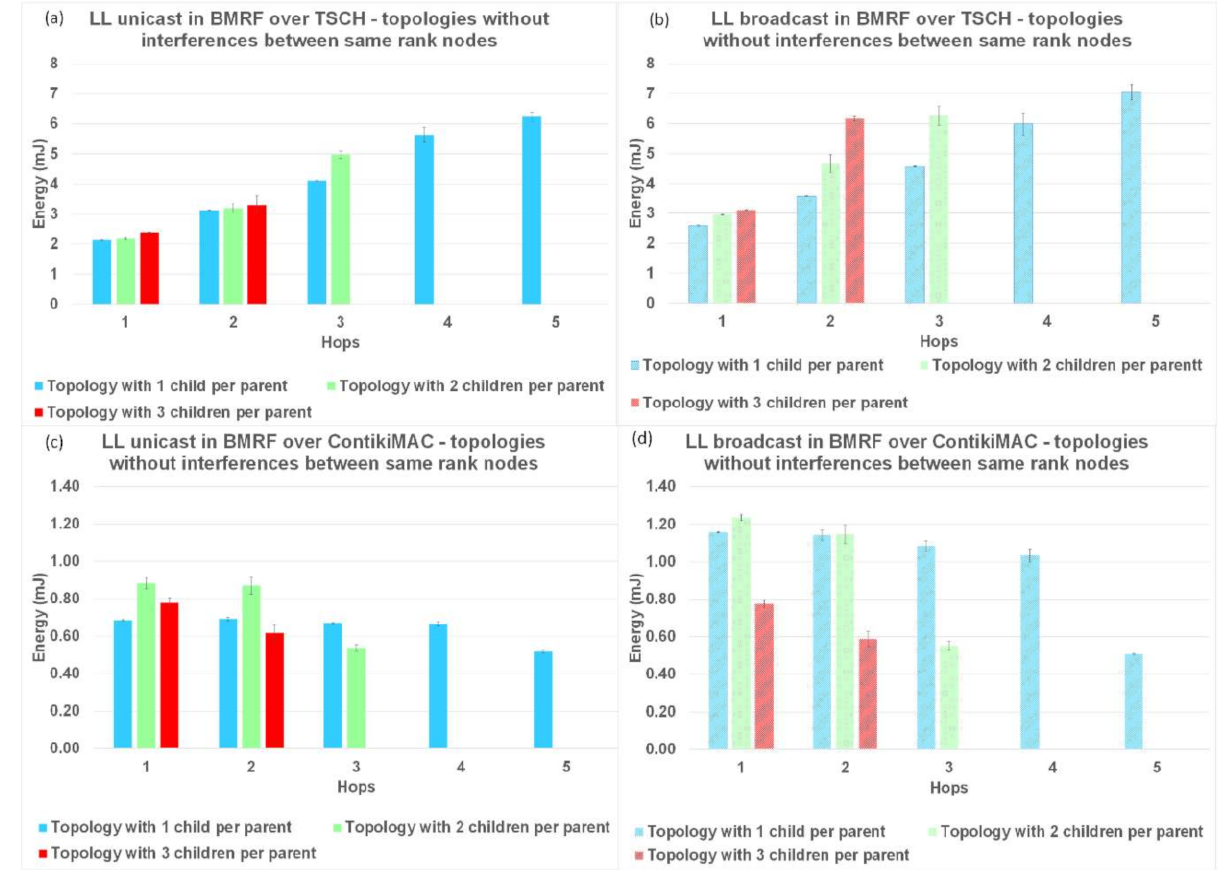
Figure 15. Energy comparison between LL unicast and LL broadcast and between ContikiMAC and TSCH on topologies with- out interference between same rank nodes. ( a ) Results for LL unicast in BMRF over TSCH. ( b ) Results for LL broadcast in BMRF over TSCH. ( c ) Results for LL unicast in BMRF over ContikiMAC. ( d ) Results for LL broadcast in BMRF over